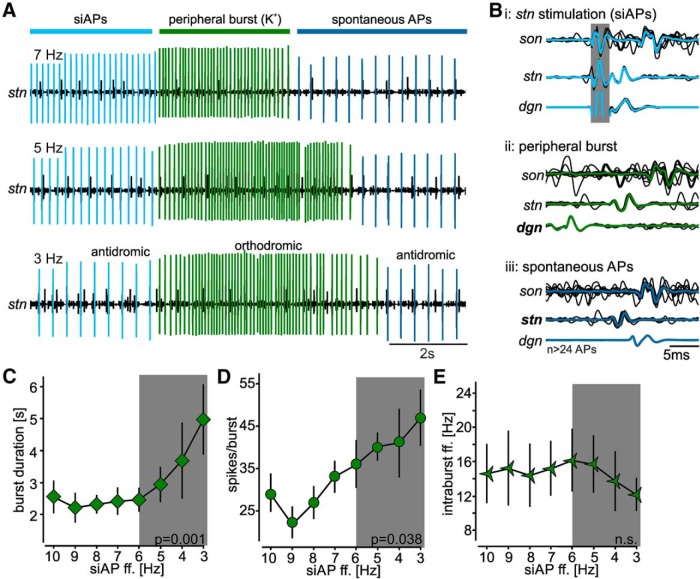
Antidromic ectopic APs alter sensory sensitivity to K+ application. A, Original recordings of AGR’s burst activities at different ectopic spike frequencies (7, 5, 3 Hz). Recordings were taken on a section of the stn, anterior to the AGR ectopic SIZ. Sensory bursts were elicited with high potassium (K+, arrow) in the periphery, ectopic APs with extracellular stimulation of the posterior part of the stn. siAPs are highlighted in light blue. Orthodromic APs of the sensory burst are depicted in green, while spontaneous ectopic APs are highlighted in dark blue. B, Overlay of several original traces from dgn, stn, and son recordings plus average showing the directions of AP propagation for the three conditions shown in A. The gray area depicts the stimulus artifact. C–E, Quantification of sensory bursts at siAP frequencies between 3 and 10 Hz. C, Burst duration. D, Number of spikes per burst. E, Average intraburst ff. The gray area indicates the physiologic range of AGR ff. decrease caused by IV stimulation. Shown are means ± SEM. N = 5 preparations.